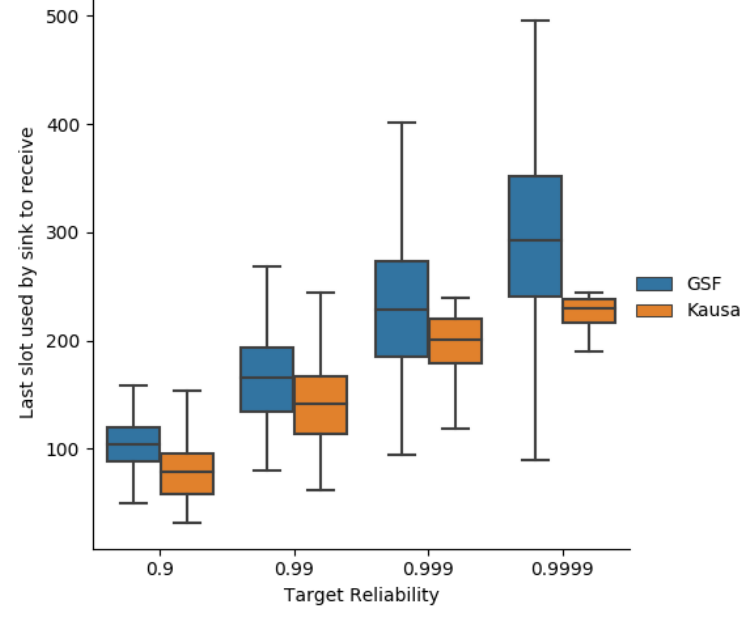
Figure 20. Schedule size obtained with MOpt and Kausa